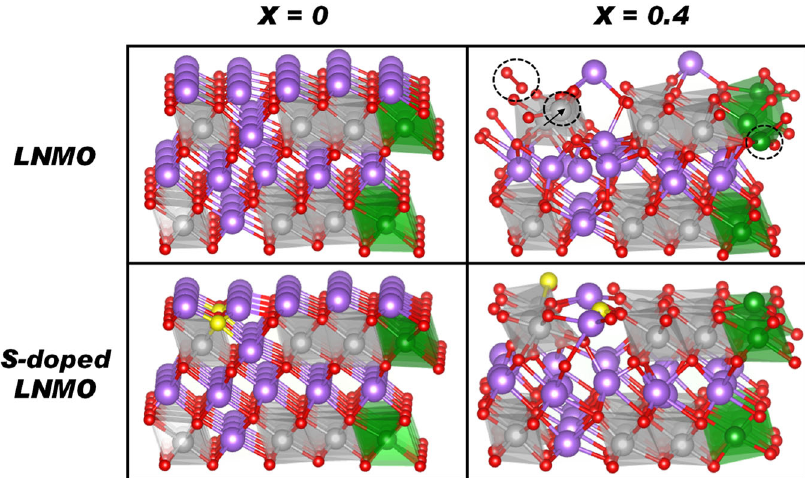
Fig. 7 Illustration of structural deformation. Side views of the optimized geometries for the pristine and S-substituted LNMO surfaces at the delithiation levels of x = 0 and x = 0.4. The black circle indicates the lattice oxygen evolution and the displacement of Ni and Mn atoms on the LNMO surface. [Color code: red- oxygen; gray- manganese; green- nickel;